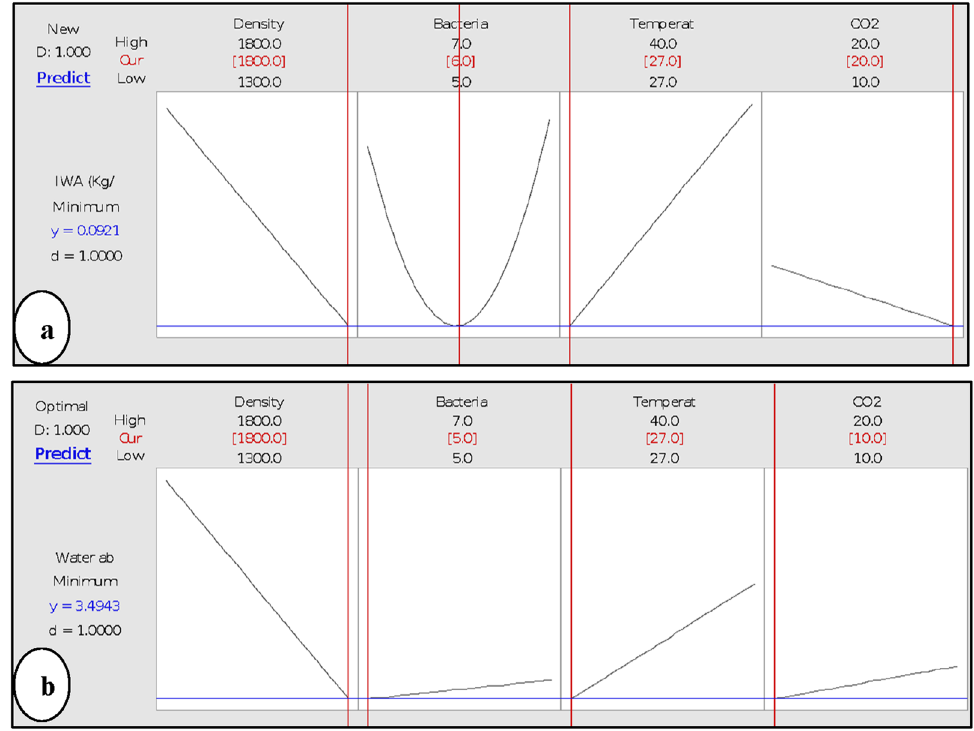
Figure 12. Optimisation plot for minimum ( a ) initial water absorption ( b ) water absorption of